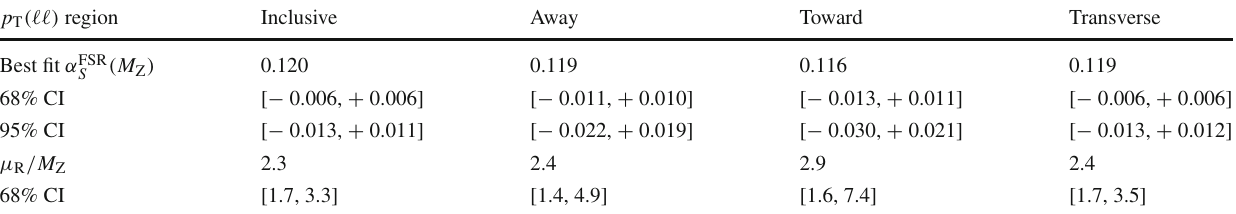
Table 4 The first rows give the best fit values for α FSR setup, obtained from the inclusive distribution of different observables and the corresponding 68 and 95% confidence intervals. The last two rows give the preferred value of the renormalization scale in units of